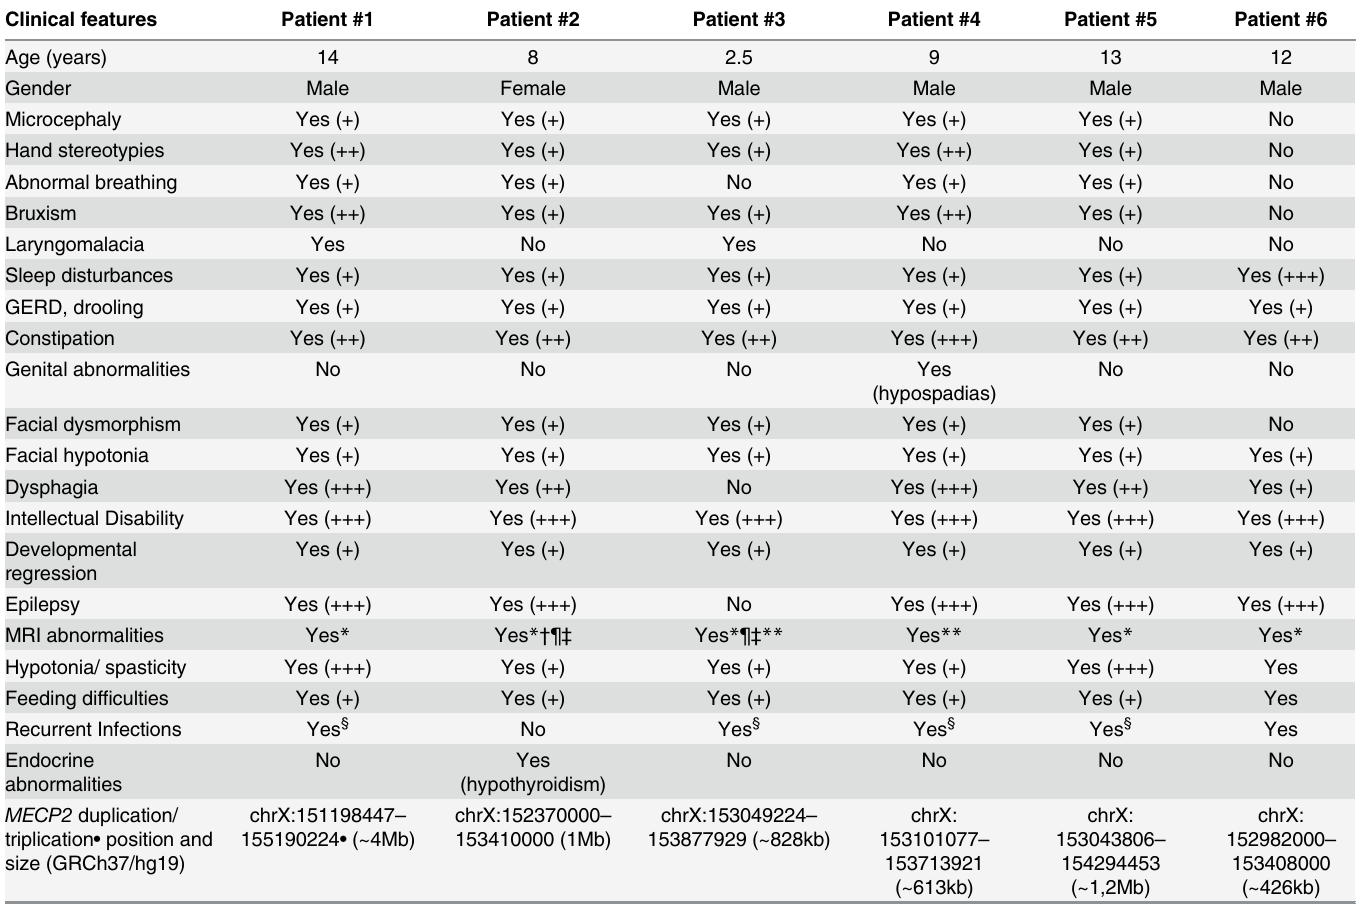
Table 1. MECP2 duplication syndrome: clinical features and genetic details. Clinical